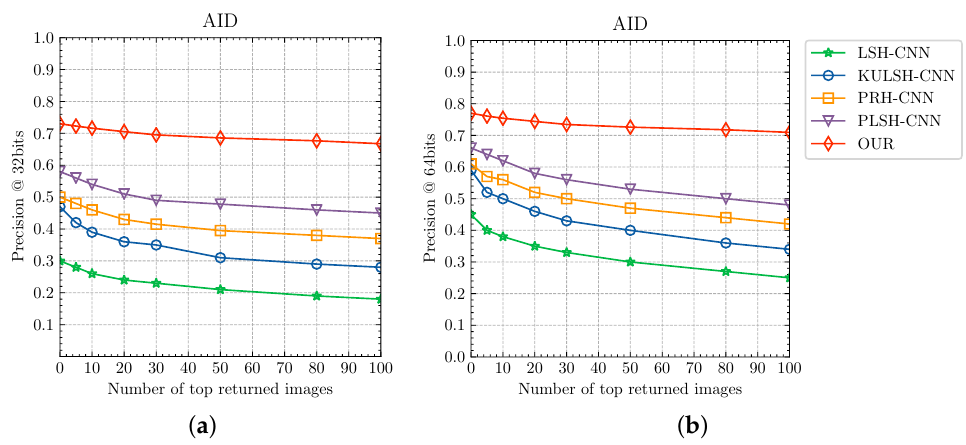
Figure 8. Precision curves with respect to a different number of retrieved images on the AID dataset. ( a ) Precision curve with regard to the top-n@32 bits. ( b ) Precious curve with regard to the top- n@64 bits.